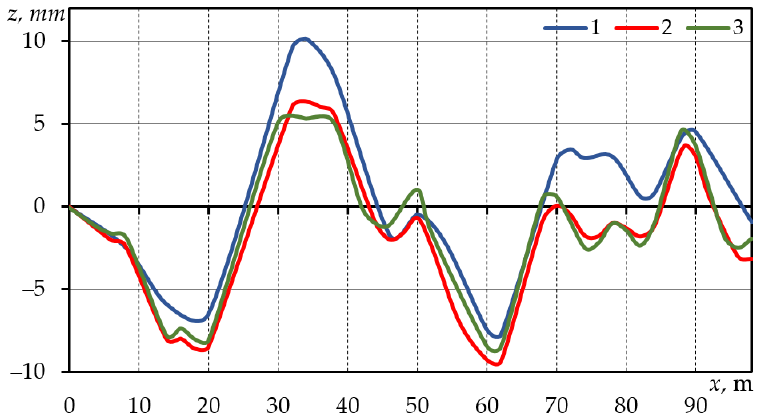
Figure 13. Vertical displacements of the sprung mass of the vehicle for driving on a smooth asphalt pavement road surface taking into account the effect of nonlinear elements: 1 — linear elements; 2 — nonlinear suspension characteristics; 3 — effect of friction on the damper frame.